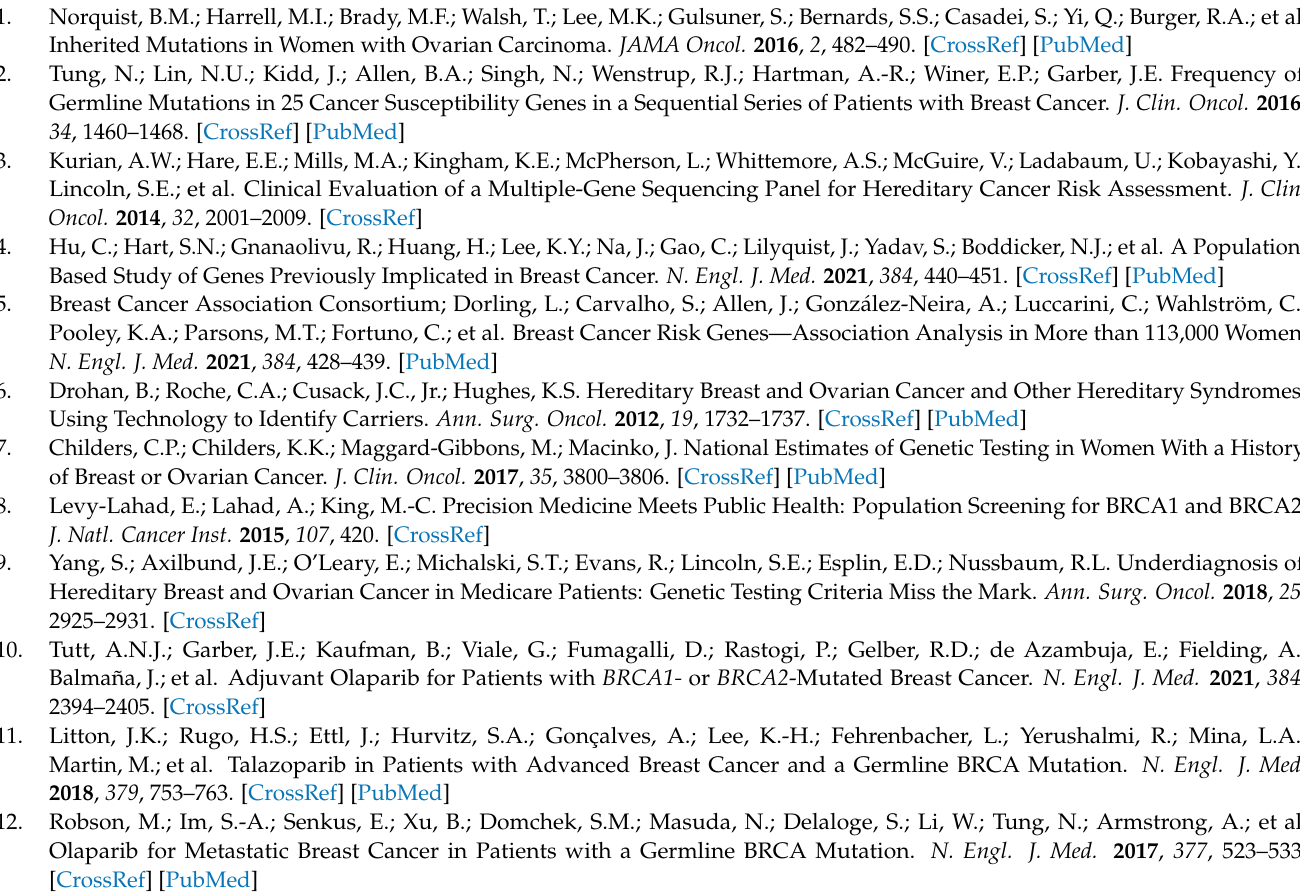
sequencing database; Table S5. Meta-analysis of gBRCA carriers in unselected breast cancer; Table S6. Meta-analysis of gBRCA carriers in ER+ breast cancer; Table S7. Meta-analysis of gBRCA in ER- breast cancer; Table S8. Meta-analysis of gBRCAin unaffected individuals; Table S9. Meta-analysis of gBRCA1 carriers in unselected breast cancer; Table S10. Meta-analysis of gBRCA2 carriers in unselected breast cancer; Table S11. Meta-analysis of gBRCA1 carriers in unaffected individuals; Table S12. Meta-analysis of gBRCA2 carriers in unaffected